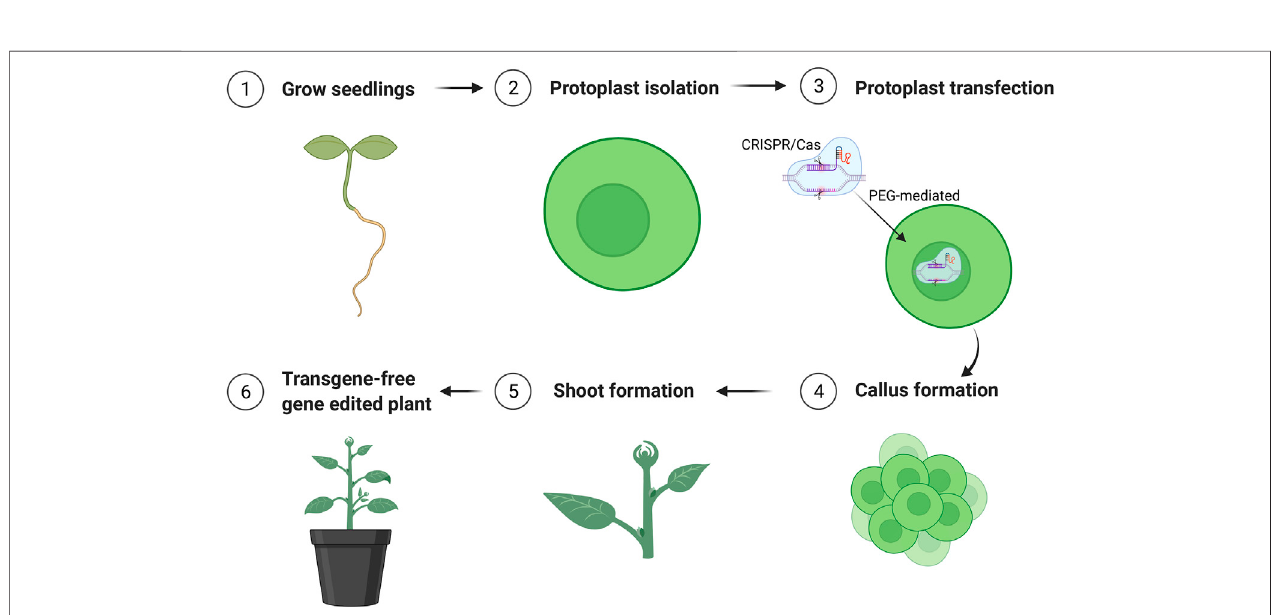
FIGURE 3 | Schematic fl owchart of generation of transgene-free mutation lines edited by CRISPR/Cas9 using protoplast approach. The fi gure was created with BioRender.com.